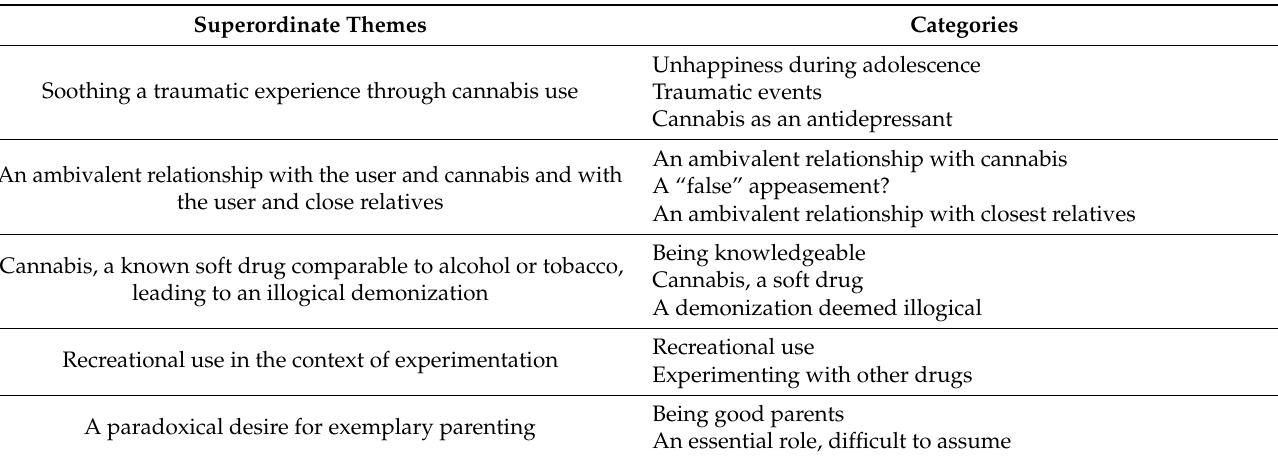
Table 2. Superordinate themes and